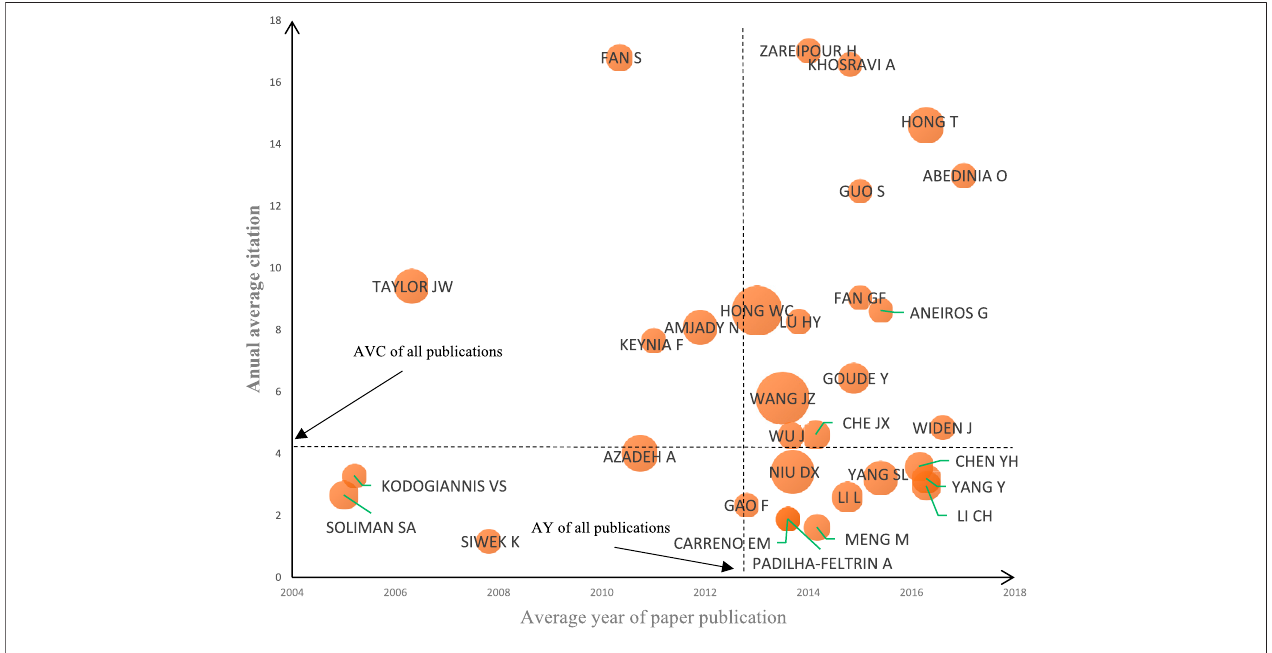
FIGURE 5 | Distribution of main authors in electricity demand forecasting, 1999 – 2018.